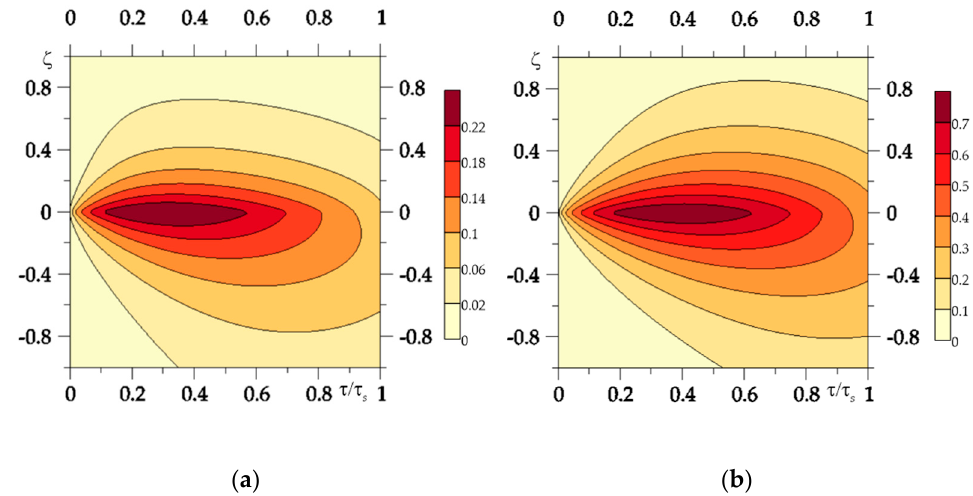
∗ Θ for: ( a ) thermally sensitivity ma-